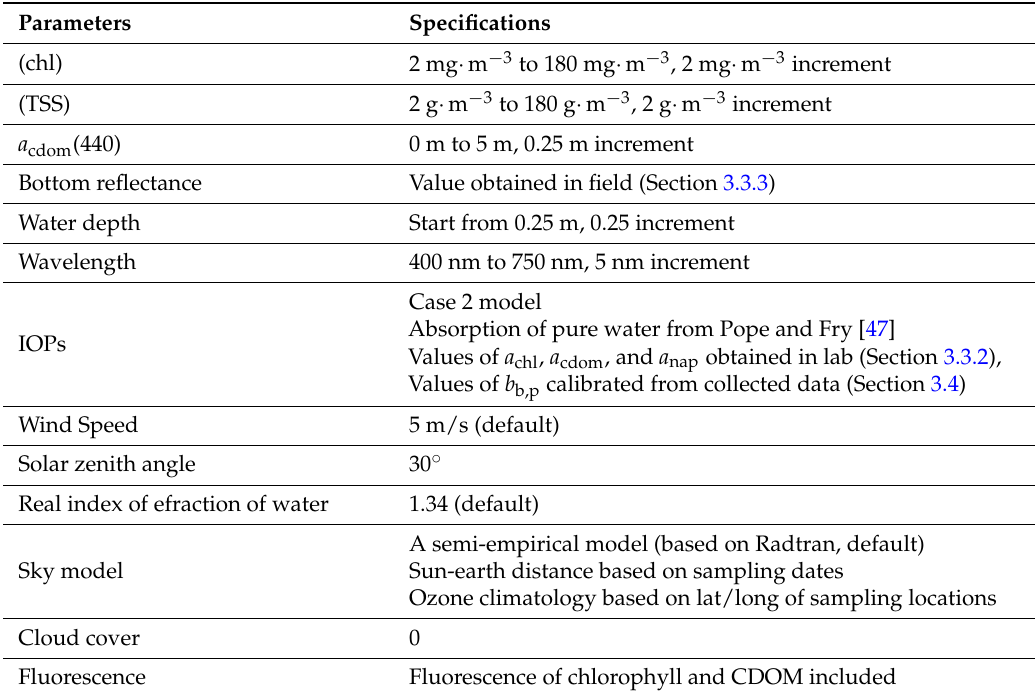
Table 3. List of specifications of all the parameters for HydroLight-EcoLight